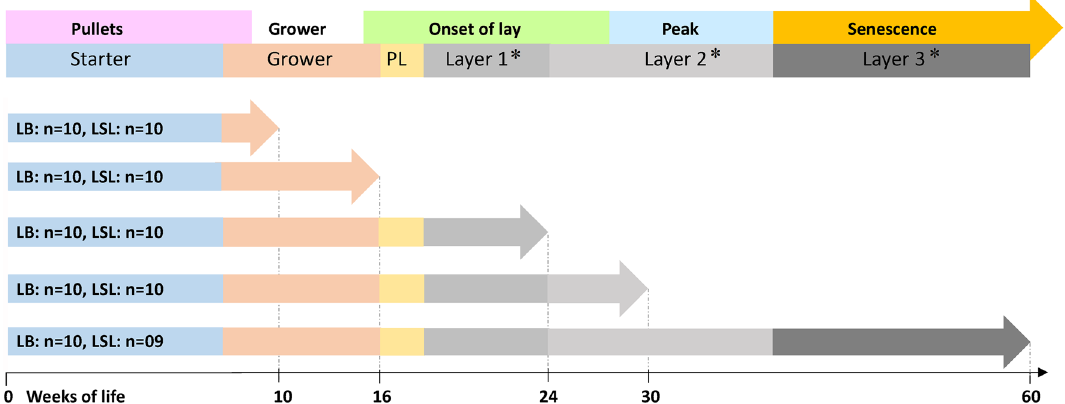
Figure 5. Dietary regimen for LB and LSL laying hen strains throughout the entire production period. Jejunal mucosa scrapings and plasma samples were retrieved at week 10, 16, 24, 30, and 60 to cover relevant production stages. Asterisks indicate a four-fold increase in the dietary calcium level to address the physiological demands from the onset of egg production. LB—Lohmann Brown; LSL—Lohmann Selected Leghorn;